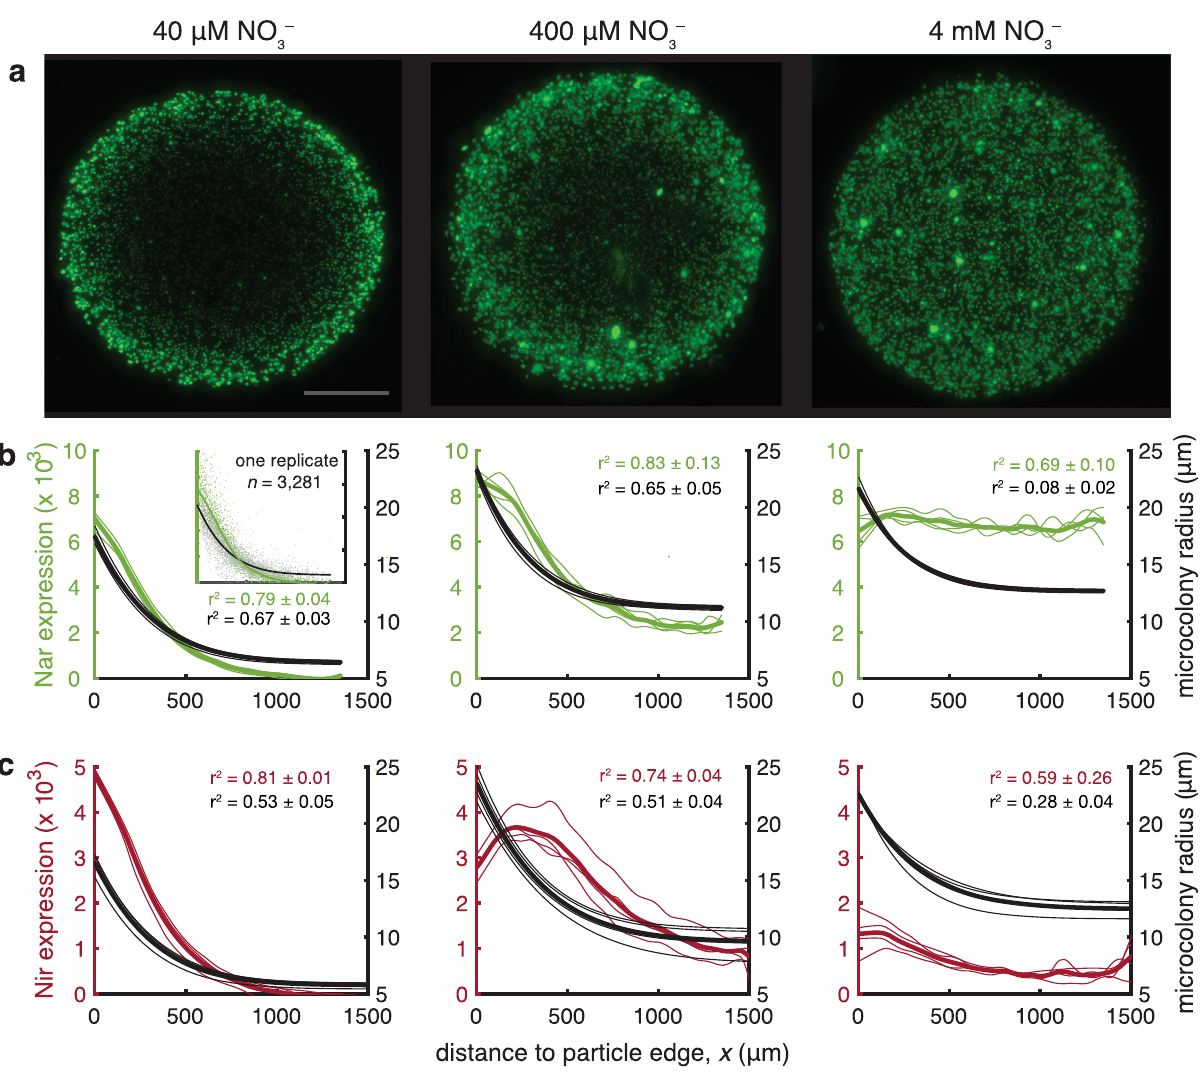
Fig. 2 Denitri fi cation gene expression and microcolony size within particles in fully anoxic fl uid. a Example images showing PAO1 microcolonies expressing NarK-GFP (nitrate reductase) after 40 h of growth in bulk anoxic media amended with 3 nitrate concentrations. Scale bar = 700 μ m. b Mean relative expression of NarK-GFP for microcolonies, and mean radii of those microcolonies, shown in relationship to the radial distance to the nearest particle edge. The mean NarK-GFP expression for microcolonies in each particle (3 – 4 replicates) is indicated by a thin green line and the mean for all particles by a thick line. Similarly, an exponential model fi t of microcolony radii for each particle is indicated by a thin black line and the mean for all particles by a thick line inset, Results for one example particle in a , illustrating the data for n microcolonies relative to the respective fi ts for those data. c Same as b but for reporter strain NirS-dsRed (nitrite reductase) expression in separate particles incubated in